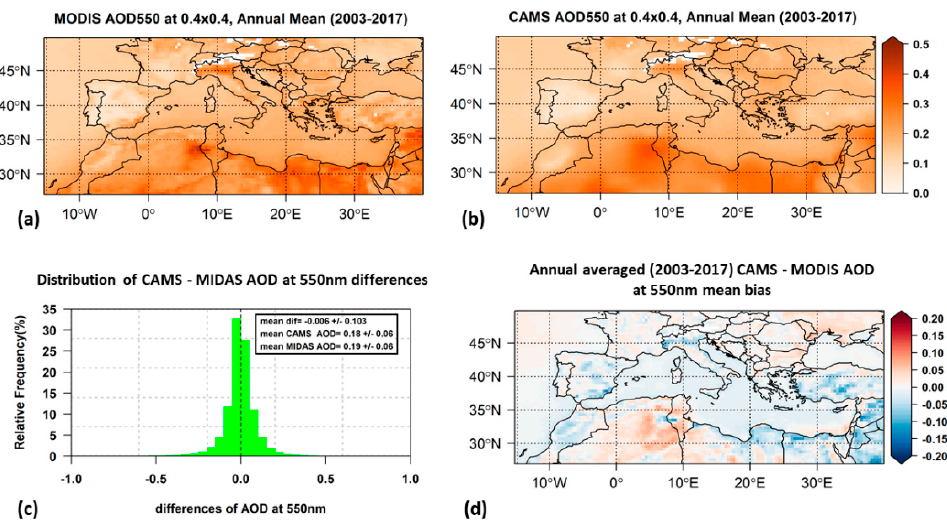
Figure 4. Geographical distribution of long-term average of annual mean AOD at 550 nm from MODIS ( a ) and CAMS ( b ). Frequency distribution of CAMS–MODIS AOD biases with their mean value ( c ) and geographical distribution of annual mean biases ( d ). Blank grid points are those that did not fulfill the criterion of at least 20% data availability on annual basis.